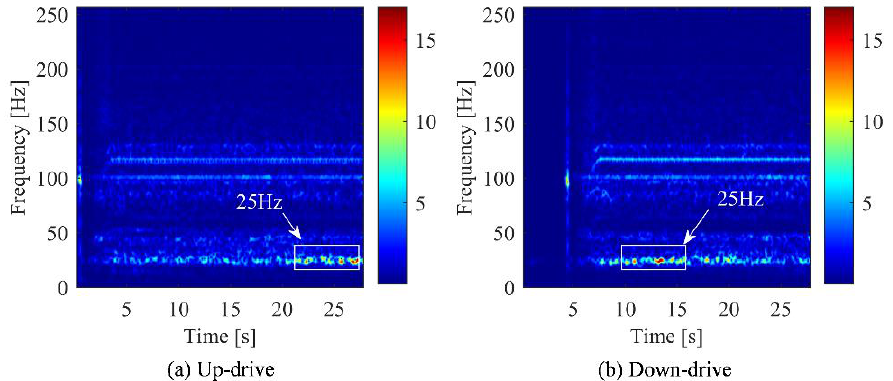
Figure 3. Time-frequency diagram of main engine vibration at elevator running speed of 1m/s. ( a ) Motor with up-drive condition. ( b ) Motor with down-drive condition.